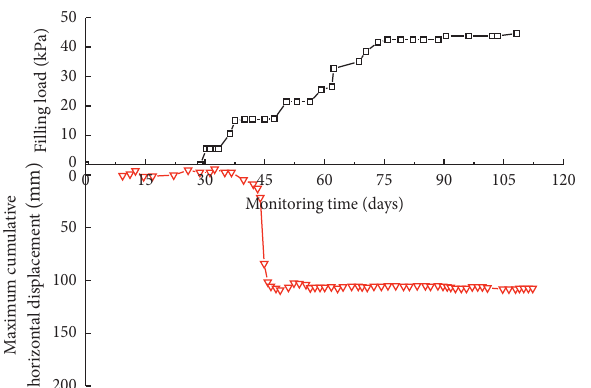
Figure 17: Variation of maximum cumulative horizontal dis- placement with filling load.